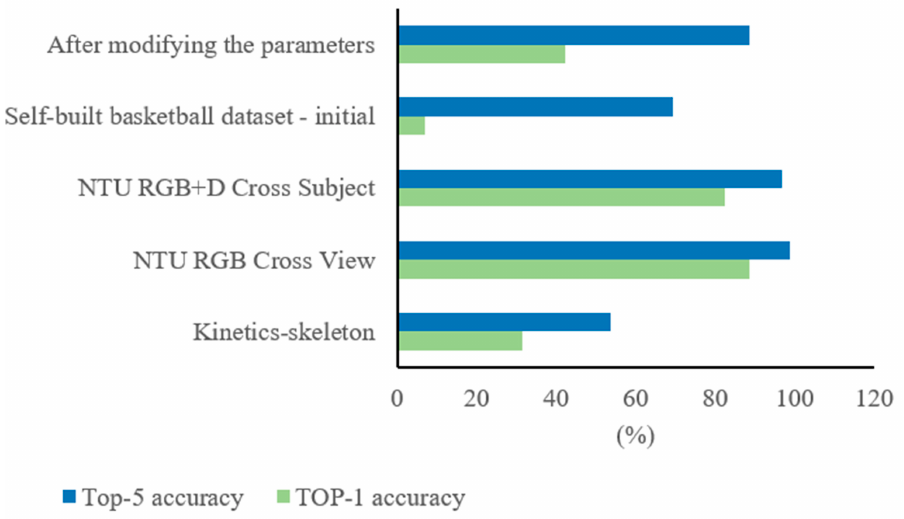
Figure 7. Recognition results of the same method on different datasets.